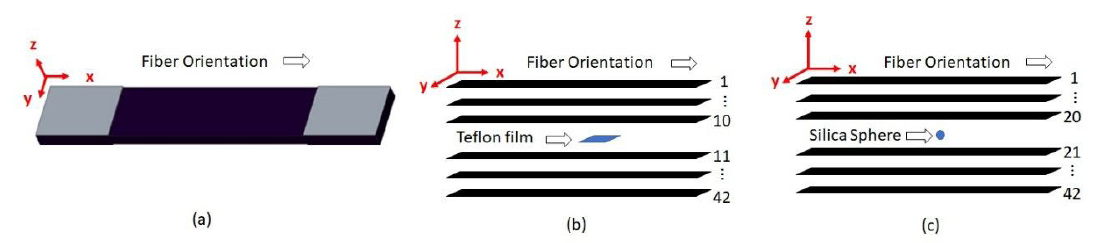
Figure 4. Sample scheme (a) rectangular sample; (b) Teflon between layers; (c) silica sphere between